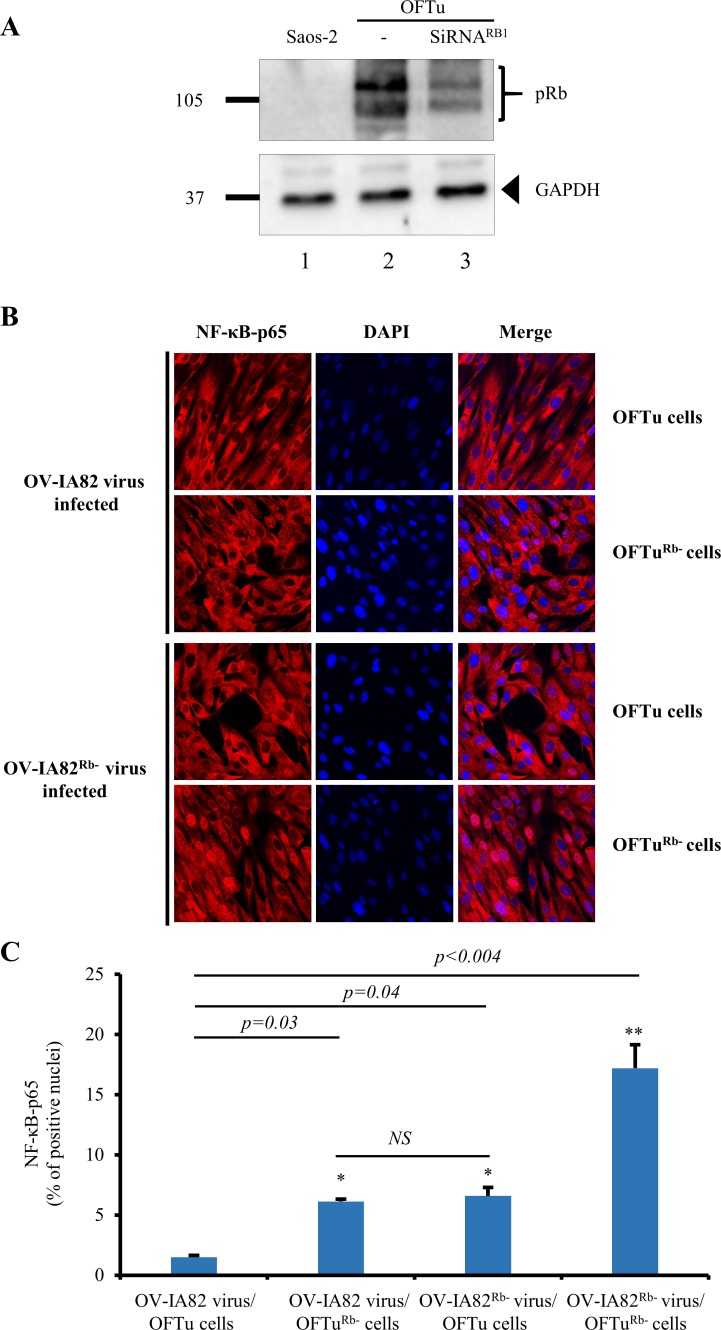
pRb affects ORFV119-mediated inhibition of NF-κB signaling in OFTu cells.(A) Western blot analysis of pRb expression in Saos-2 cells (Lane 1) and OFTu cells untreated (Lane 2) or treated with siRNA for RB1 (Lane 3) as described in Materials and Methods. Loading control, GAPDH. (B) OFTu or OFTuRb- cells were infected with OV-IA82, OV-IA82Rb- virus as described in Materials and Methods and cells were fixed at 1 h p.i. sequentially probed with antibody against NF-κB-p65 and Alexa Fluor 594 labeled secondary antibody, counterstained with DAPI, and examined by confocal microscopy. Red, NF-κB-p65; Blue, DAPI. (C) Cells were counted (n = 500 cells/slide) and results are shown as percentage of cells expressing nuclear NF-κB-p65. Results are mean values from two independent experiments. *P<0.05 (OV-IA82 virus/OFTu cells vs OV-IA82 virus/OFTuRb- cells), *P<0.05 (OV-IA82 virus/OFTu cells vs OV-IA82Rb- virus/OFTu cells, **P<0.01 (OV-IA82 virus/OFTu cells vs OV-IA82Rb-/OFTuRb- cells; no significance (NS) for (C) OV-IA82 virus/OFTuRb- cells vs OV-IA82Rb- virus/OFTu cells.